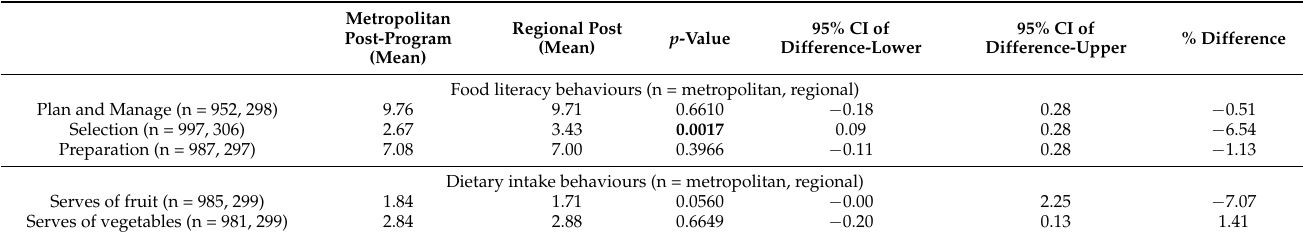
Table 7. Two-tailed t-tests comparing metropolitan vs. regional post-program scores for the three food literacy behaviour domains and change in self-reported dietary intake of fruits and